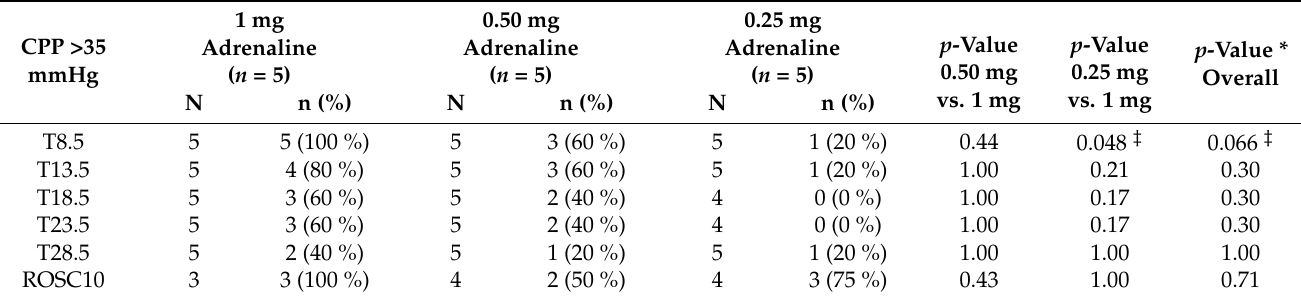
Table 3. CPP threshold of 35 mmHg 90 s after adrenaline injection in the three compared groups.